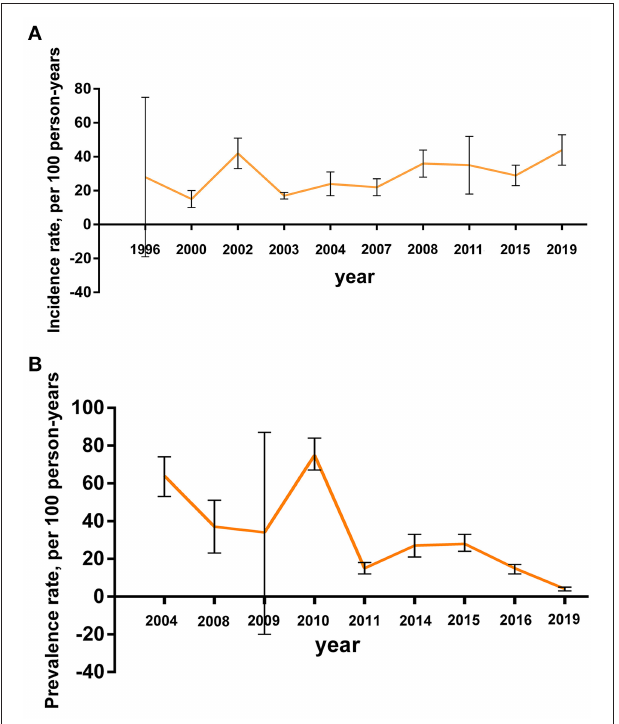
FIGURE 4 | Annual trend. (A) The annual incidence rate of PSSP; (B) The annual prevalence rate of